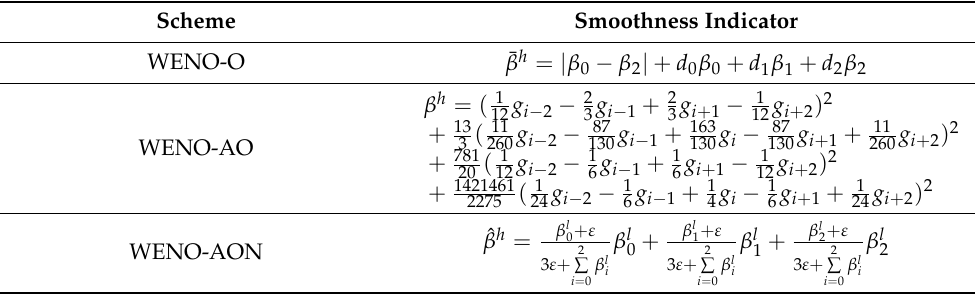
Table 2. Comparison of smoothness indicator of the adaptive order schemes (WENO-AO and WENO-AON) and proposed WENO-O